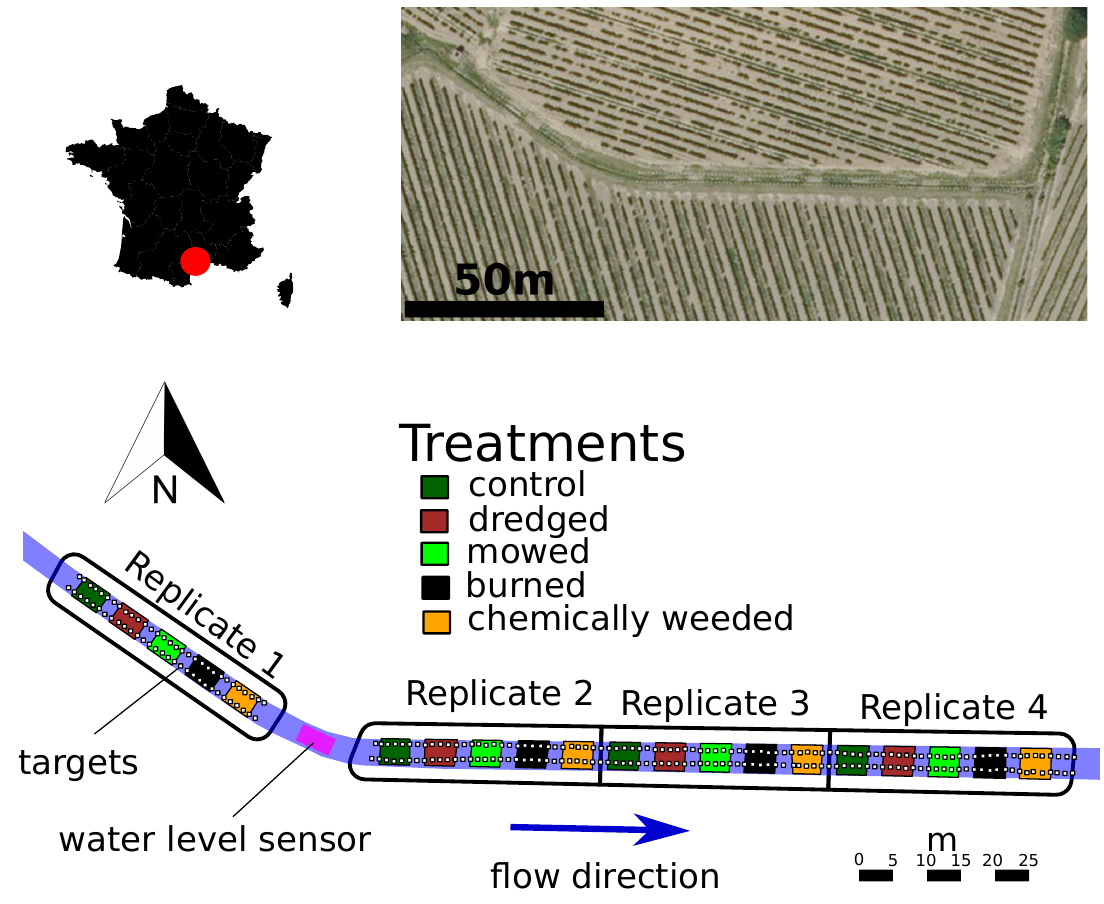
Figure 1. Location of the study site and sequence of maintenance practices. Positions of the control points are represented by white squares. Colored polygons represented the areas of each maintenance